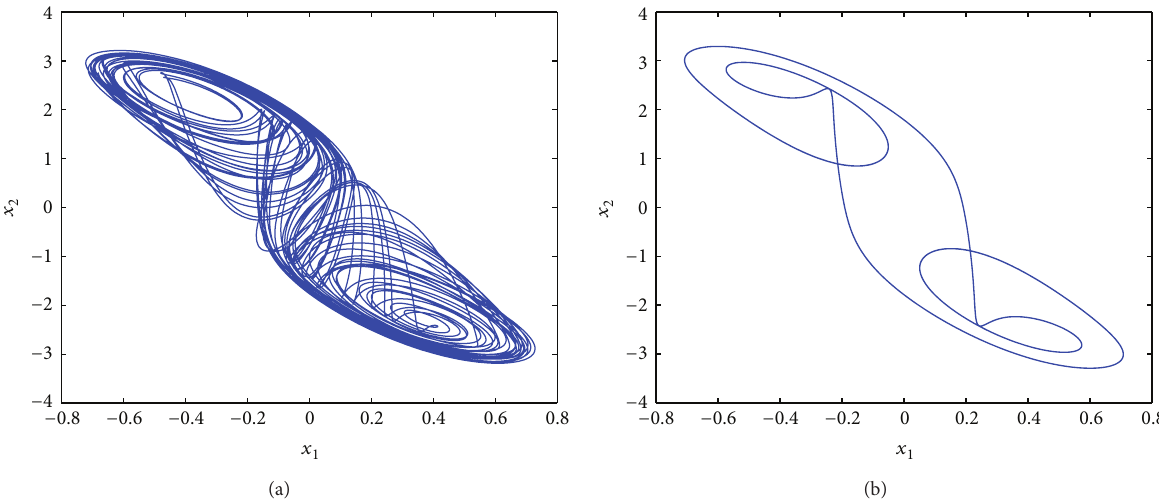
Figure 2: (a) Double-scroll chaotic attractor when 𝛼 = 0.92 with the initial condition (0.4,0.6) 𝑇 for 𝑡 ∈ [−1,0] ; (b) periodic orbit when 𝛼 = 0.99 with the initial condition (0.4, 0.6) 𝑇 for 𝑡 ∈ [−1,0] .